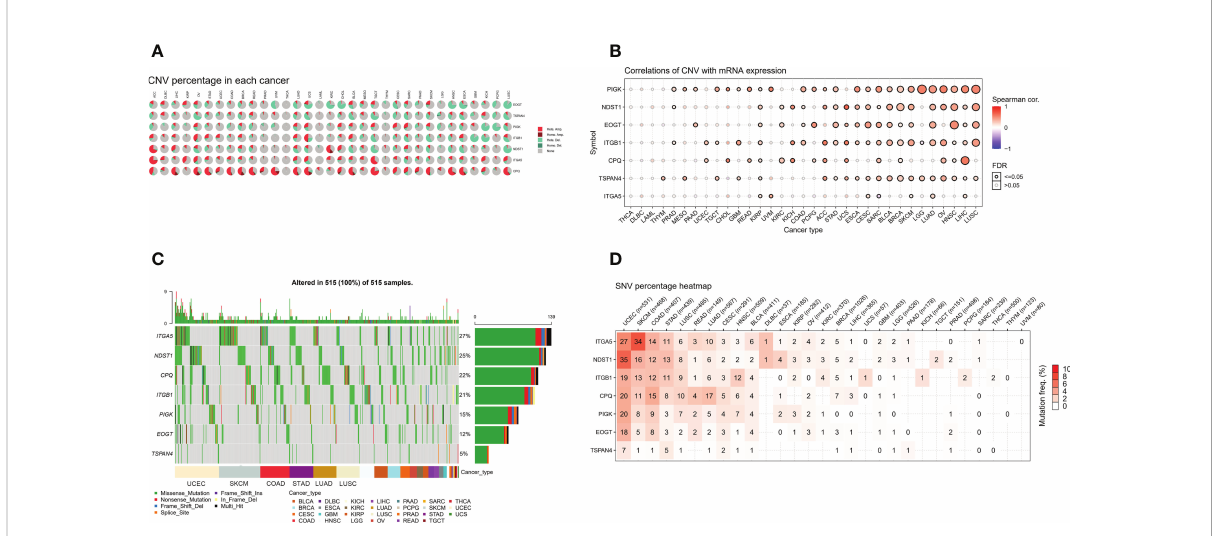
FIGURE 2 MRGs are present in a large number of genetic variants in pan-cancer. (A) Copy number variation (CNV) in the MRGs. CNV pie charts show the heterozygous/homozygous CNV for each gene in each cancer for this combination. (B) Correlation of the migrasome mRNA expression with CNV. The statistical signal is represented by the size of the dots, where the larger the dot, the greater the statistical signal. (C) The SNV oncoplot shows the distribution of mutations, MRGs, and migrasome SNV types. Sidebar and top bar show the amount of mutations in each gene. (D) SNV frequencies of genes in cancer. The higher the mutation frequency, the darker the color. The percentage of samples with the respective mutated gene for a given cancer is indicated by